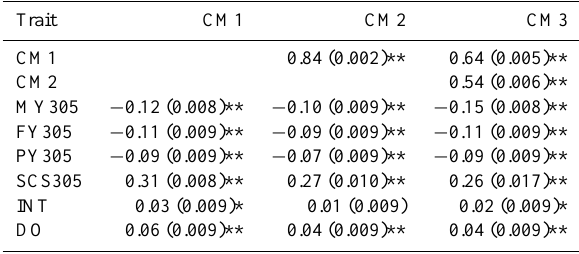
Table 6. Estimates of residual correlations between CM traits, SCS, and milk production, including their standard errors (in parenthe-